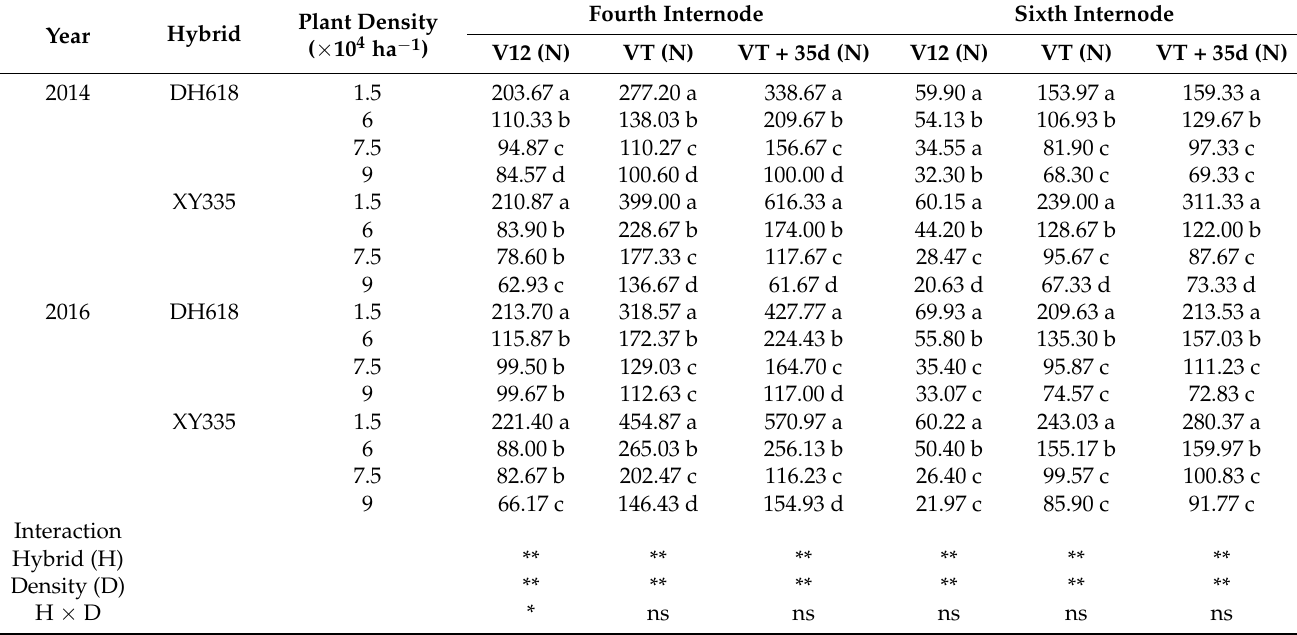
Table 3. Bending strength of DH618 and XY335 at different growth stages in 2014 and